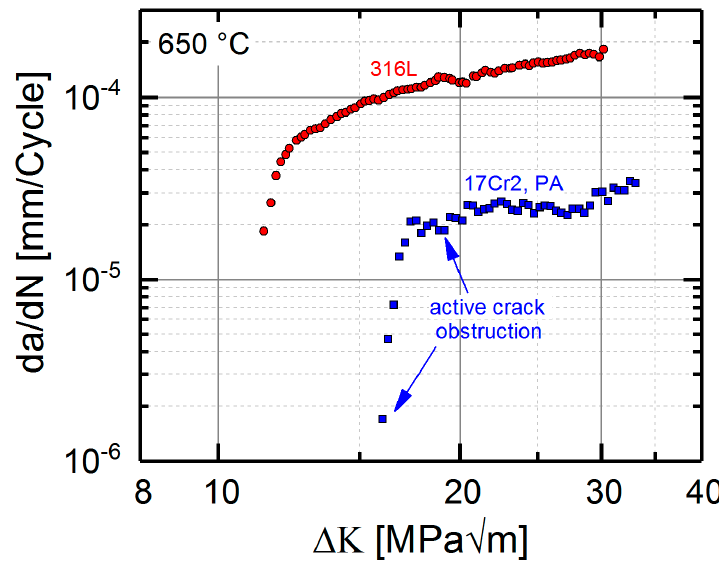
Figure 20. FCG data of 316L and HiperFer 17Cr2 (after precipitation annealing: 0.5 to 10 h from 600– 650 °C) at 650 °C [18]. 600–650 ◦ C) at 650 ◦ C